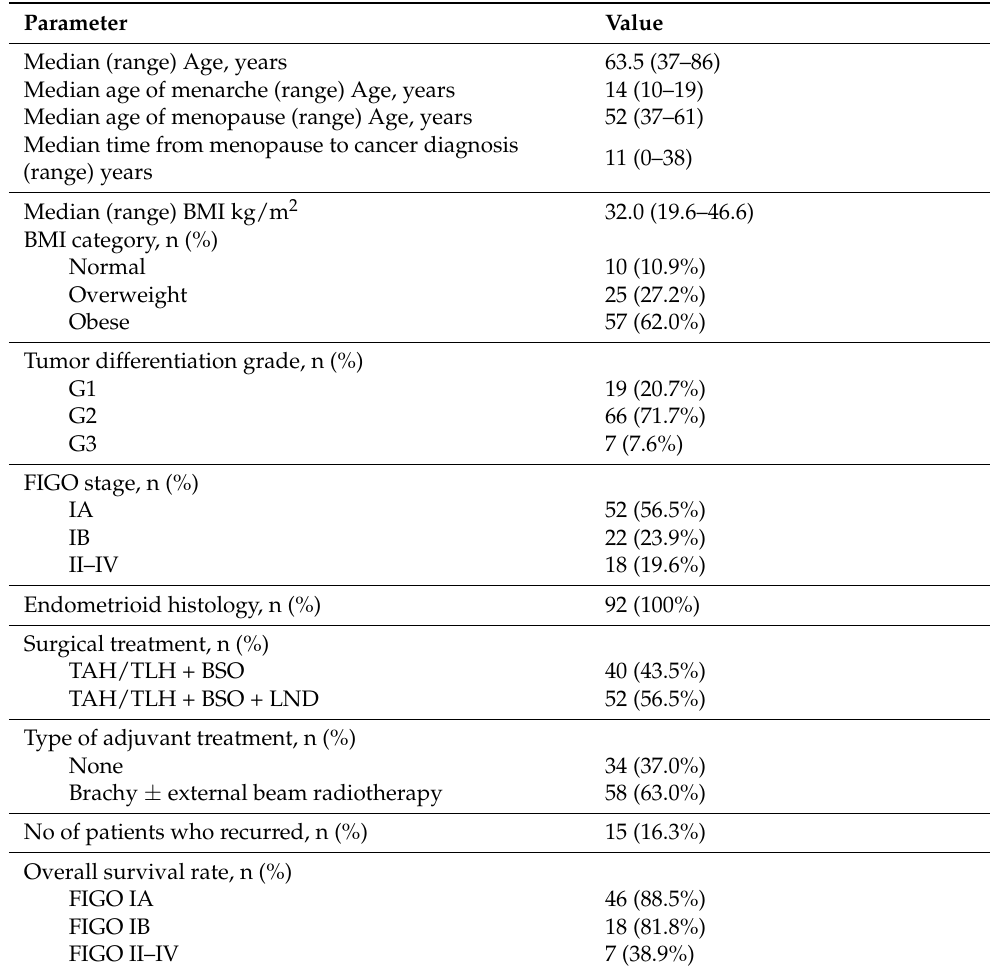
Table 1. Clinicopathological characteristics of 92 endometrial cancer patients included in the study. BMI: body mass index; FIGO: the International Federation of Gynecology and Obstetrics; TAH: total abdominal hysterectomy; TLH: total laparoscopic hysterectomy; BSO: bilateral salpingo- oophorectomy; LND: lymphadenectomy.